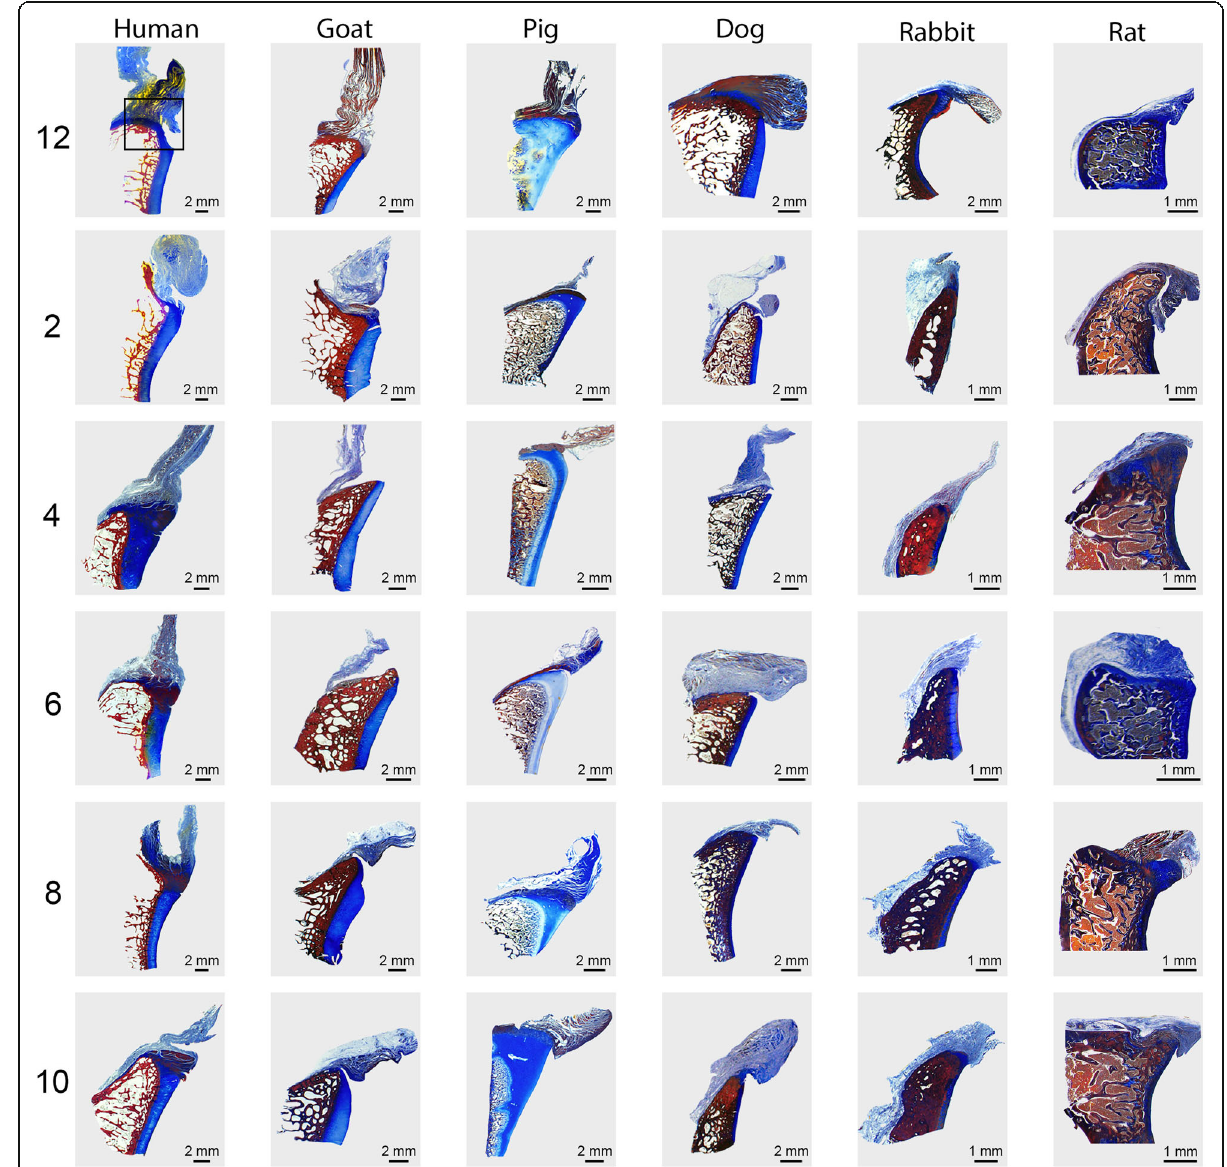
Fig. 4 Lower magnification Mallory trichrome-stained sections of the glenocapsular junction at each clockface position across species. Box on human 12 o ’ clock image (top left) indicates higher magnification region of interest shown in Fig.